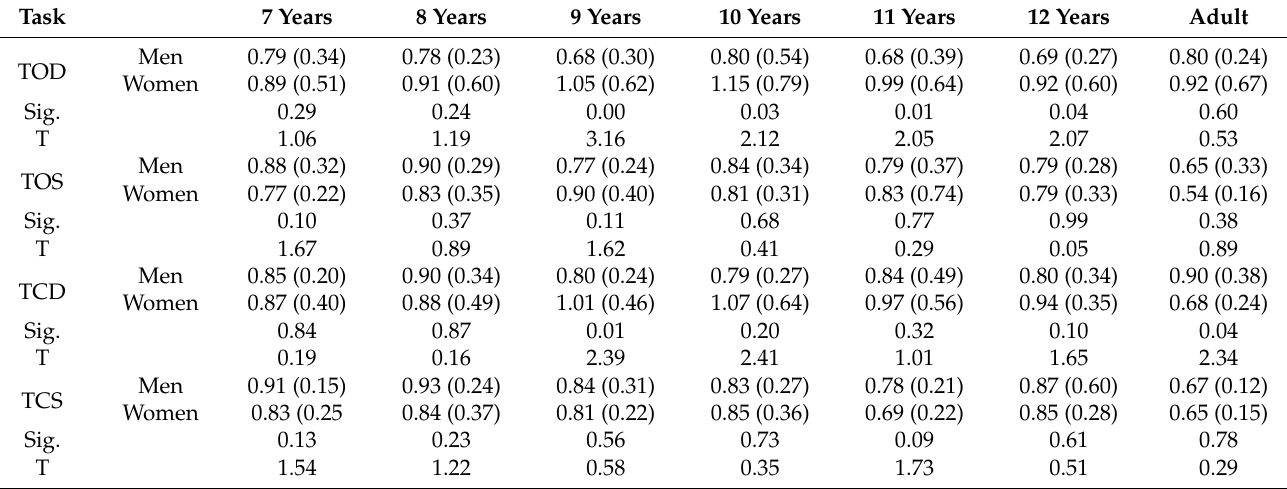
Table 2. Comparison of male and female participants regarding PS in the AP